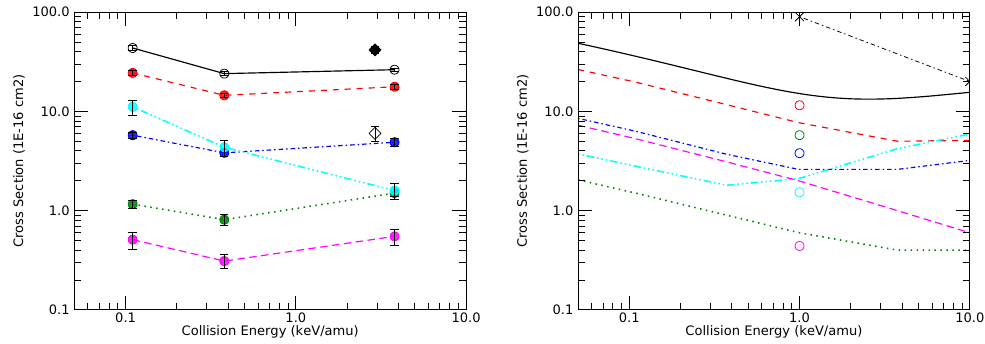
Figure 4. ( Left ) Experimental velocity dependence of deduced K-series emission and total charge-exchange cross-sections for collisions between C 5 + and H 2 O. Indicated are total cross-sections (black solid line); the forbidden line z (dashed red line); intercombination line x + y (green dotted line); resonance line w (blue dashed-dotted line); K β (cyan dash-double dot); and K γ (magenta dashed line). Single and double charge-changing cross-sections measured by Mawhorter et al. [29] are represented by a filled and open diamond, respectively. ( Right ) Theoretical emission and total capture cross-sections. Colored lines indicate MCLZ calculations by Mullen et al. [22]. Open circles represent CTMC calculations for emission cross-sections by Otranto et al. [30]. The stars represent CTMC calculations of the total one-electron capture cross-section by Liamsuwan and Nikjoo